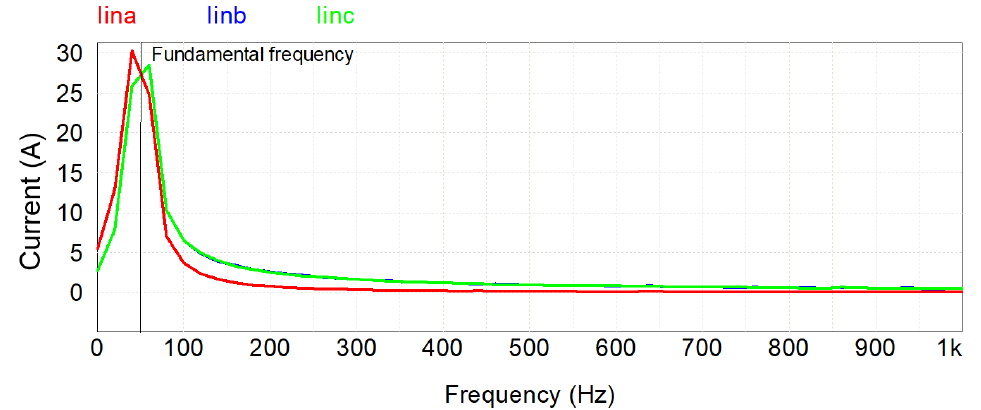
Figure 12. FFT of input currents.